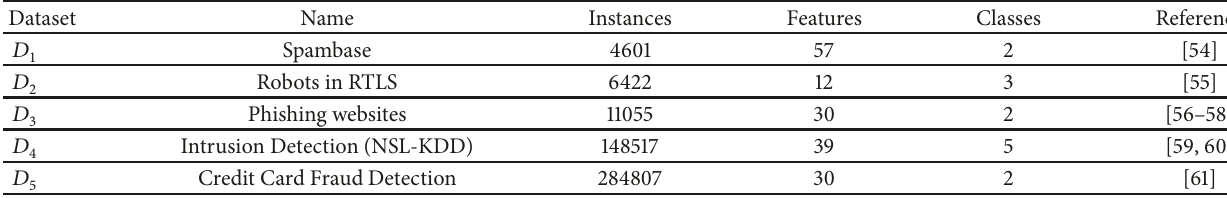
Table 2: Description of the set of datasets D .